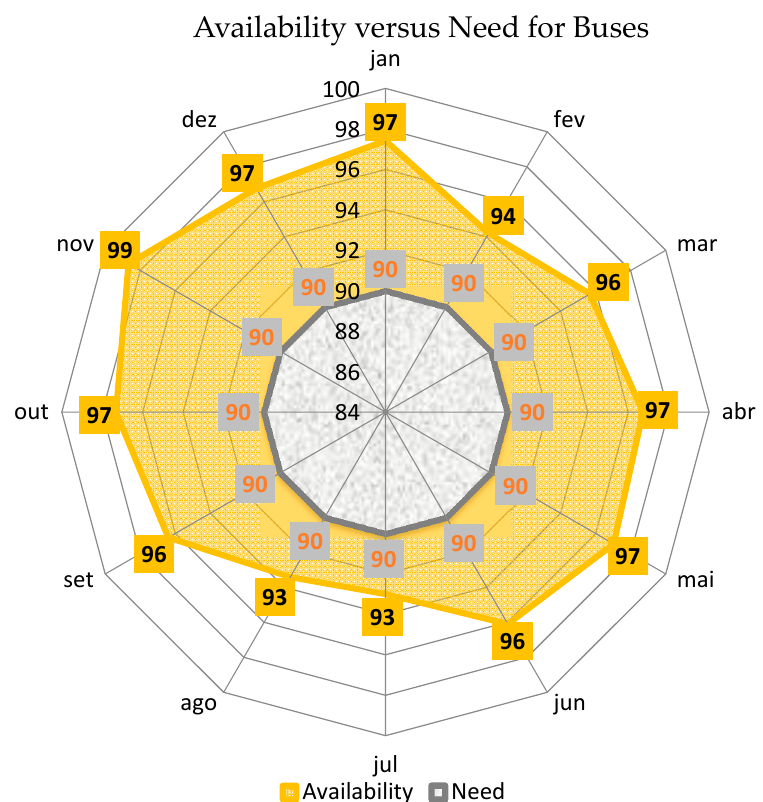
Figure 4. Availability versus Need for buses—Systematic Preventive Maintenance.